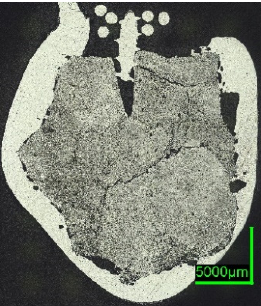
Figure 11. Digital microscope images of the HBI-ULC-2-1 sample, dipped into ULC.